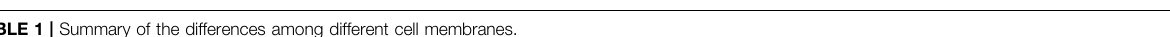
TABLE 1 | Summary of the differences among different cell